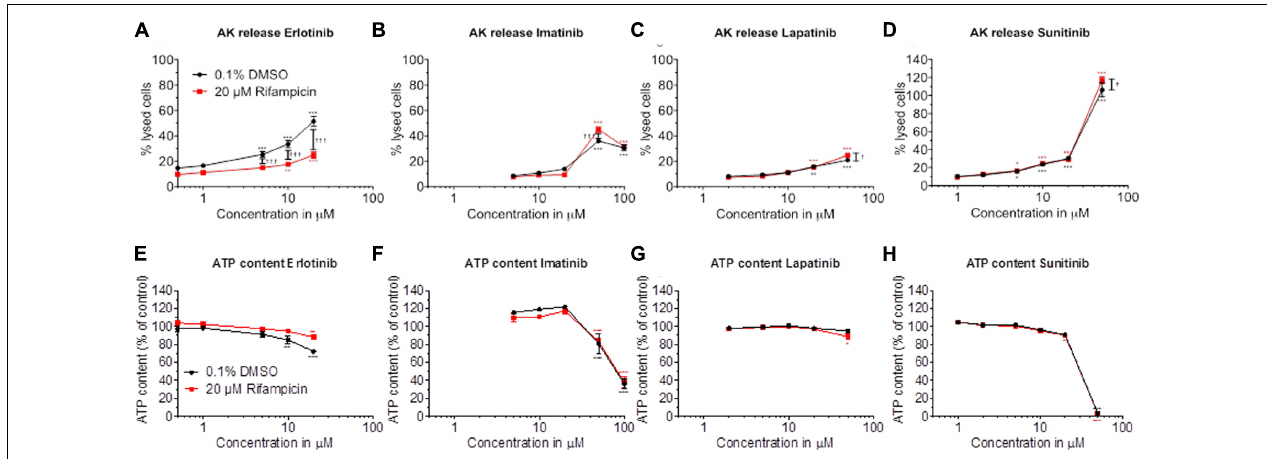
FIGURE 2 | Effect of pretreatment with rifampicin on cytotoxicity and intracellular ATP content in HepaRG cells. HepaRG cells were pretreated for 72 h with rifampicin and then exposed to drugs for 48 h. Cytotoxicity was assessed by the release of AK. (A–D) Cytotoxicity of erlotinib, imatinib, lapatinib, and sunitinib, respectively. (E–H) Intracellular ATP content of erlotinib, imatinib, lapatinib, and sunitinib, respectively. Data are expressed as % AK release in the presence of 0.5% Triton X (set at 100%) or as % ATP content in the presence of 0.1% DMSO (set at 100%). Data represent the mean ± SEM of at least three independent